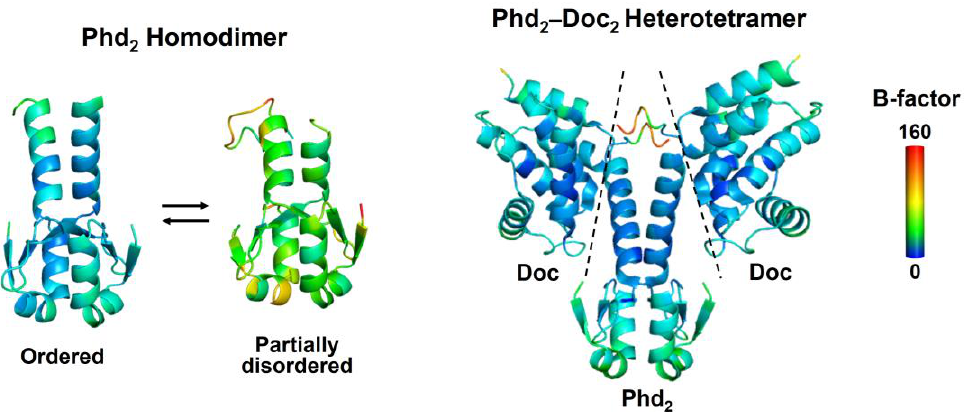
Figure 2. Crystal structures of the antitoxin Phd alone and in complex with the cognate toxin Doc. The antitoxin Phd exists in ordered or partially disordered conformations as observed in crystal structures [22] (accession number: 3HS2 for the ordered state and 3HRY for the partially ordered state). An ordered conformation of Phd in the complex with Doc is observed in the crystal structure [22] (accession number: 3K33). Crystallographic B-factors are color-mapped onto the structures. Dotted lines represent the interface between Phd and Doc.